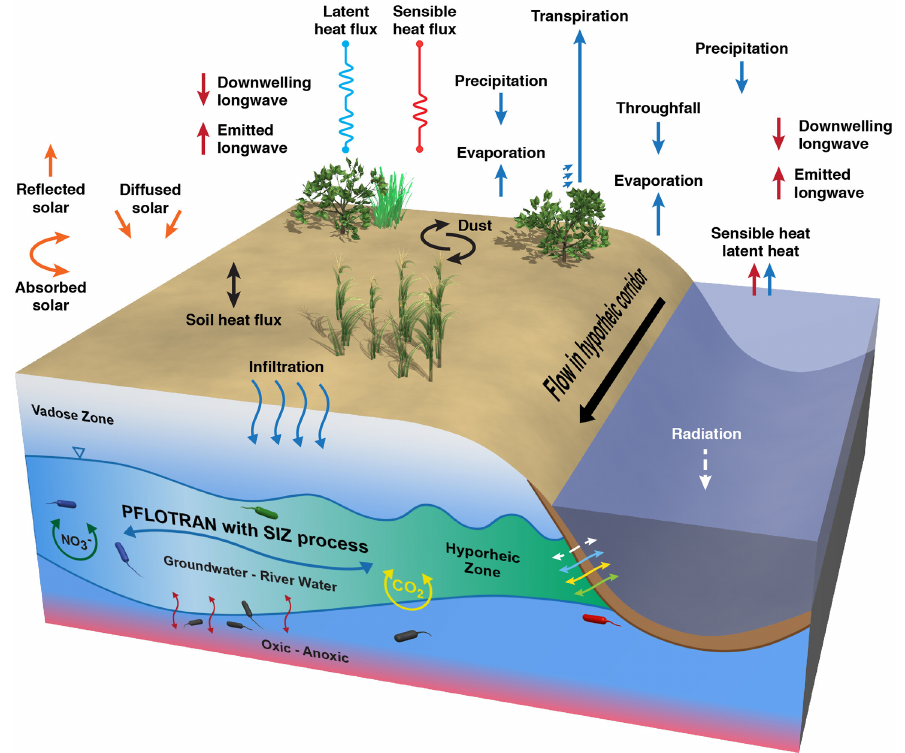
Figure 2. Schematic representation of hydrologic processes simulated in CP